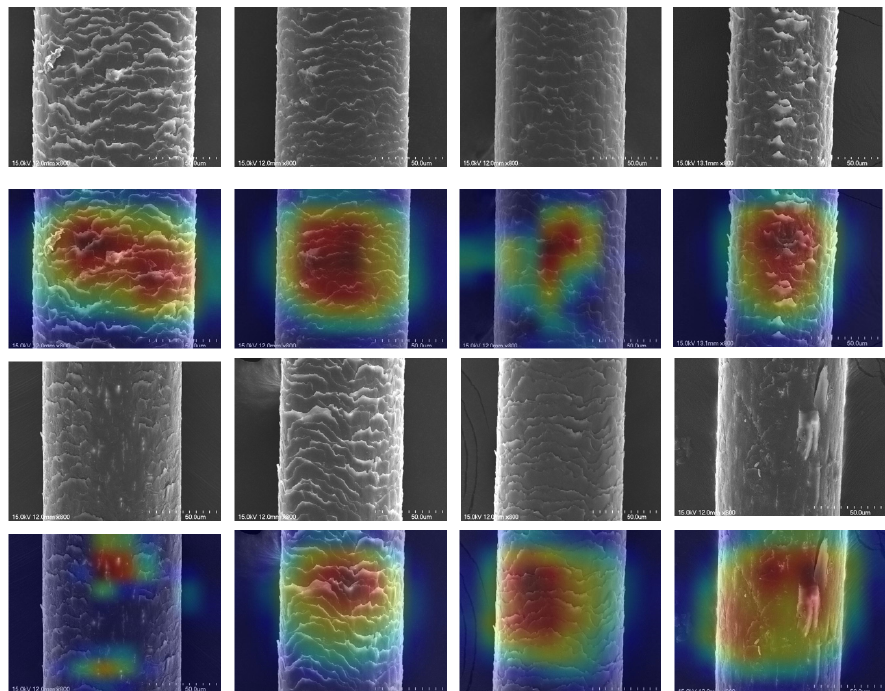
Figure 11. Attention to damaged hair area.